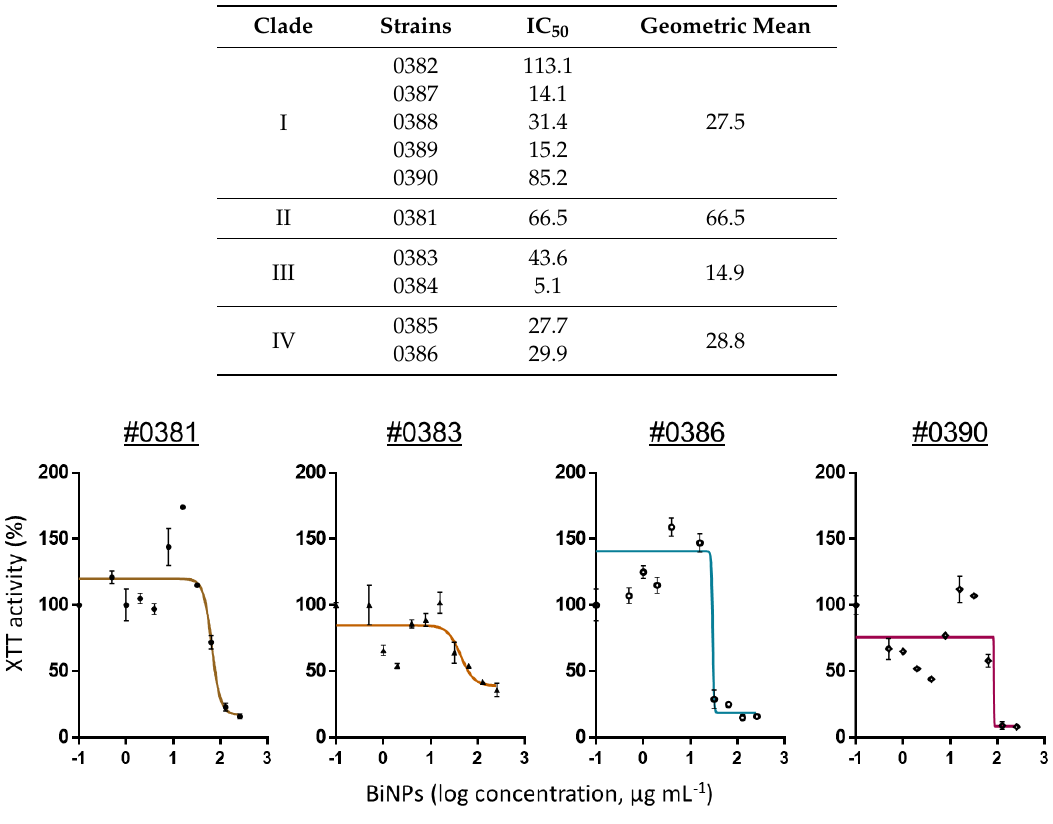
Table 2. Calculated IC 50 ( µ g mL − 1 ) for the biofilm inhibitory activity of BiNPs against C. auris strains from the di ff erent clades.